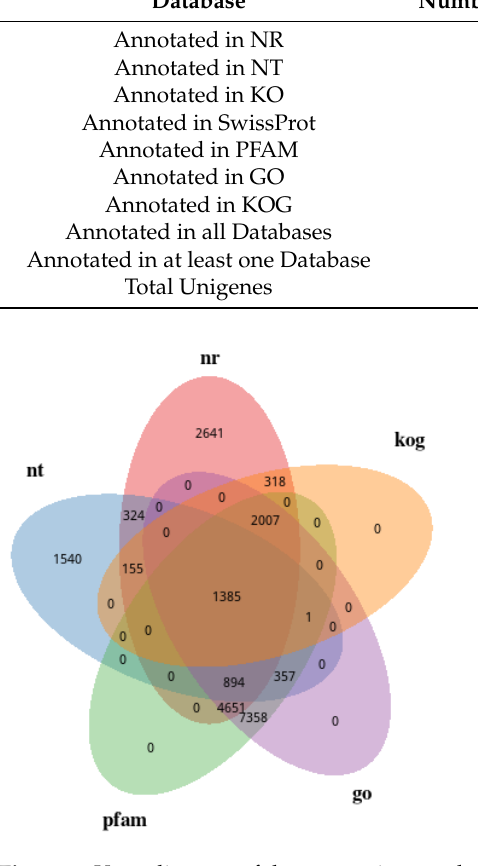
Figure 3. Venn diagram of the annotation results.